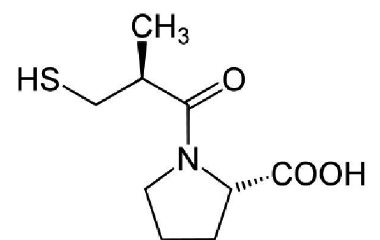
FIGURE 1 - Chemical structure of captopril.